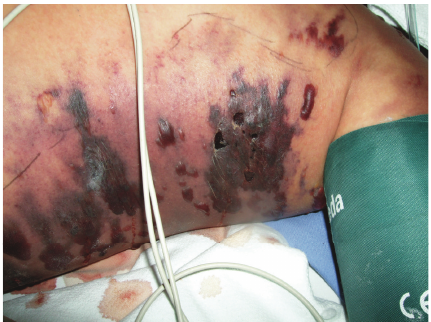
Figure 4: Left hemithorax 24 hours after admission to the PICU showing rapid progression of the skin changes and new lesions in the lateral chest wall and superior abdomen, hemorrhagic blisters, and severe edema and necrotic